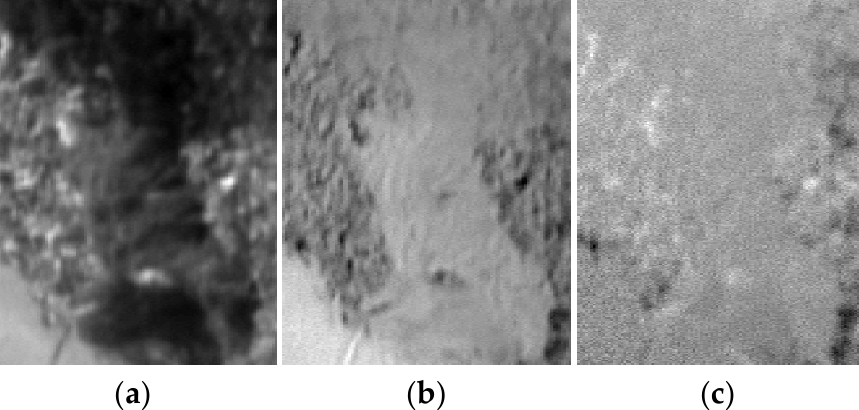
Figure 14. The first three principal component images of area A to be tested after PCA. ( a ) The first principal component image of area A, ( b ) The second principal component image of area A, ( c ) The third principal component image of area A. area B are shown in Figure